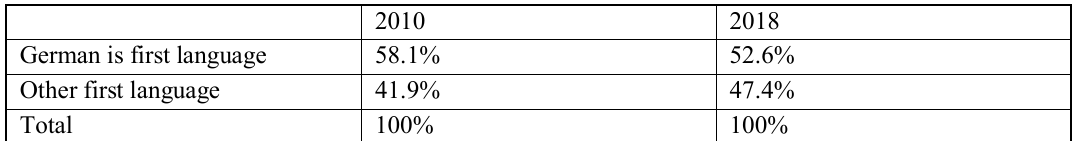
Table 5: Proportion of adults with different first languages among the low-literate